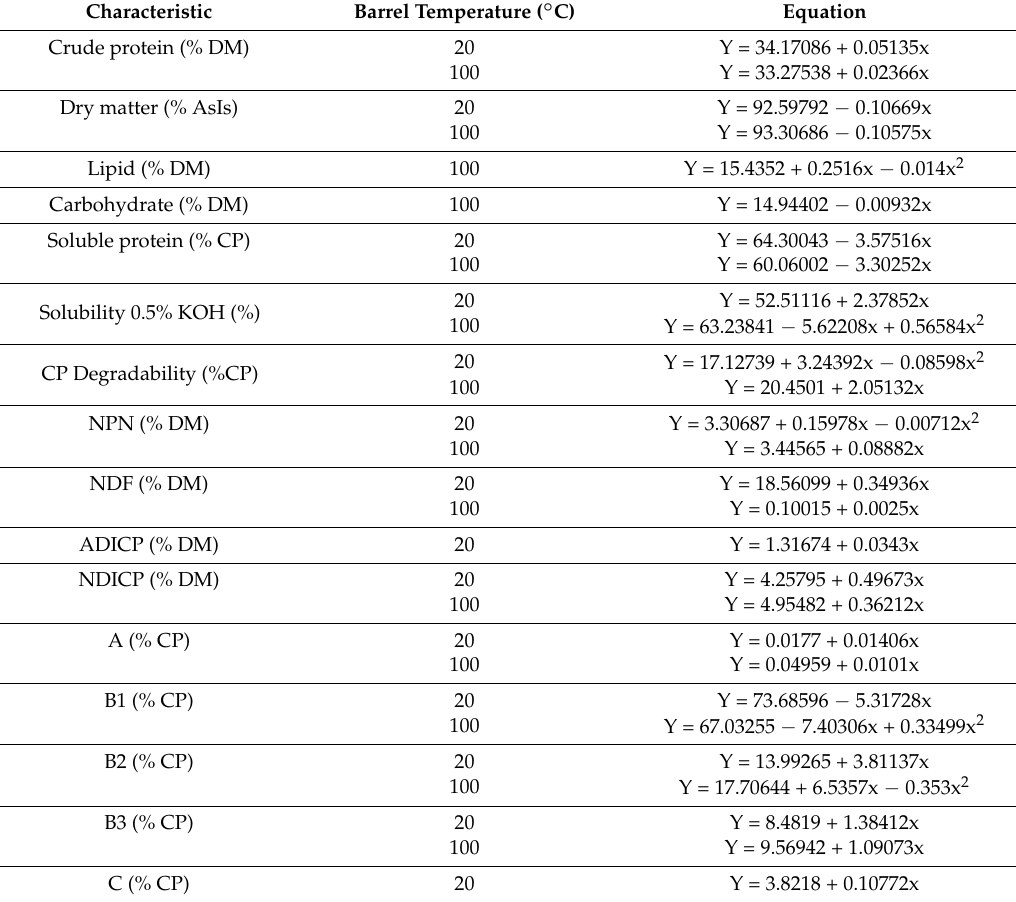
Table A1. Linear and polynomial equations to describe the effects of increasing barrel dry heat (20 and 100 ◦ C) and moist heat pressure duration on general nutritional properties, protein degradability, and protein fractionation characteristics of canola